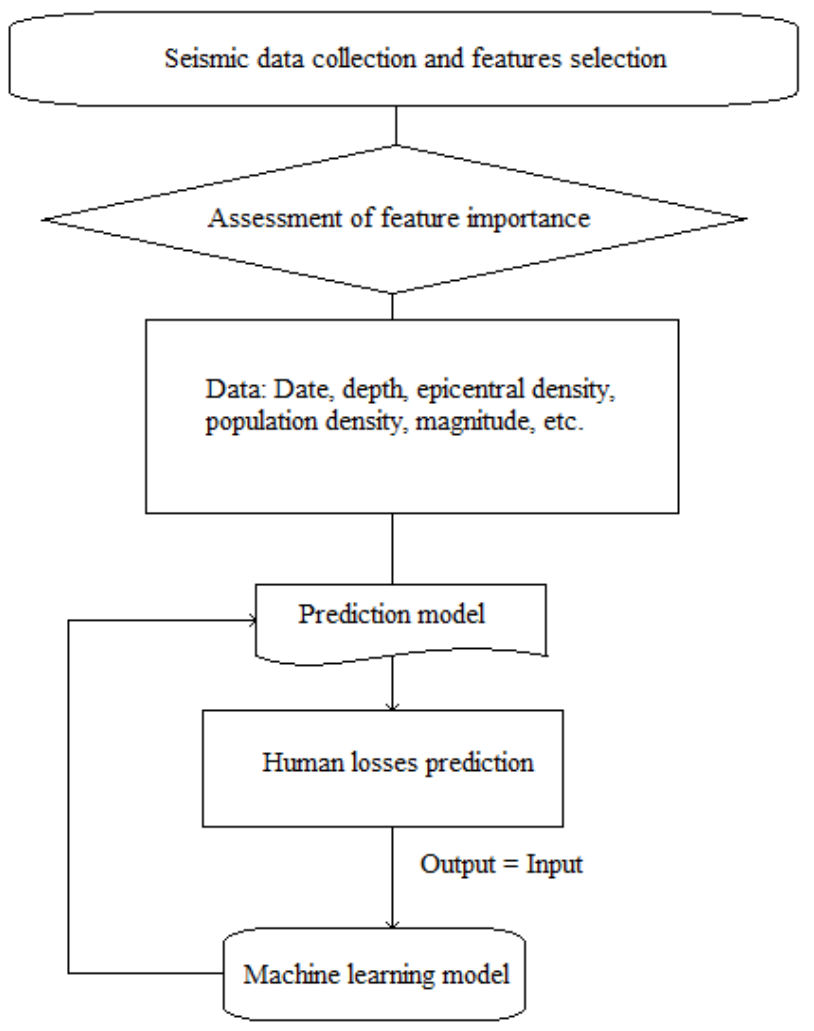
Figure 4. Flowchart for minimizing human losses with machine learning methods.